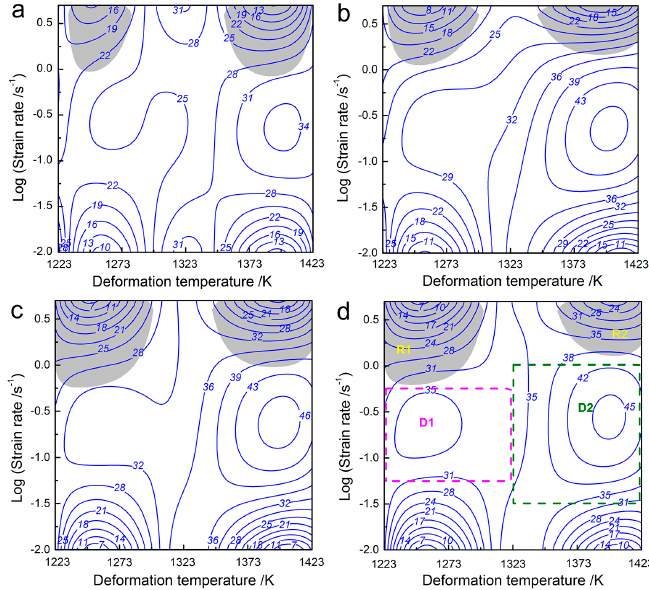
Figure 14. Processing maps of 70MnSiCrMo carbide-free bainitic steel at various strains: ( a ) 0.162; ( b ) 0.357; ( c ) 0.598; ( d ) 0.9. The square domains (D1 and D2) possess a high efficiency of power dissipation and are considered to be the suitable processing windows, while the gray regimes (R1 and R2) indicate that it is unsafe for